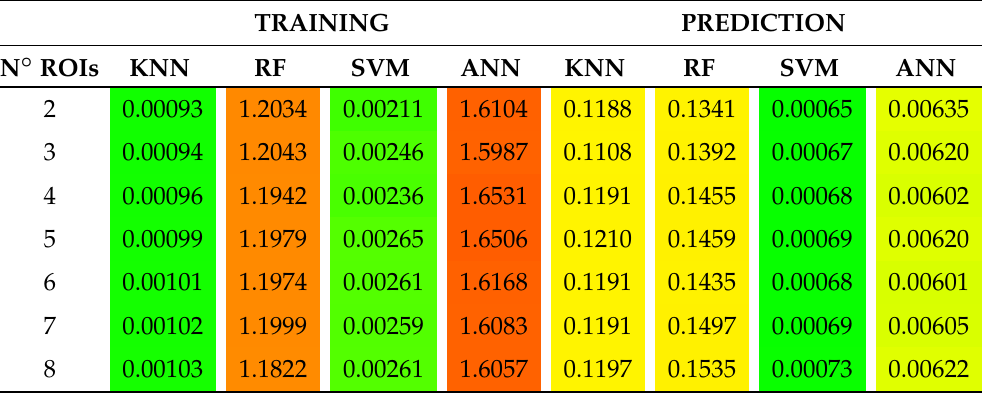
Table 4. Values of the time spent by the analyzed predictive models during the training and prediction stages, and considering different number of ROIs, expressed in